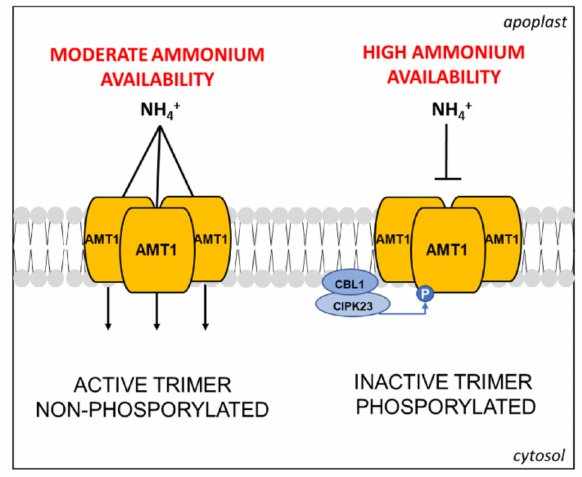
Figure 3. Schematic representation of the AMT1 trimeric complex and its control mode through CIPK23/CBL1-mediated phosphorylation induced by high NH 4+ availability, adapted from [69] (see text for further